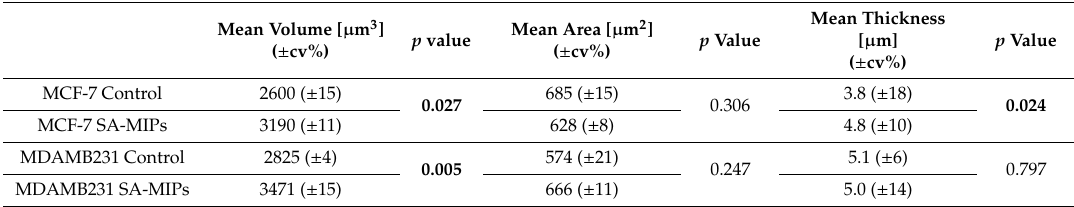
Table 1. Morphology parameters detected with DHC for MCF-7 cells and MDAMB231 cells after 72 h of SA-MIPs treatment. The results represent mean value of five positions in the wells for each condition. Statistical significance was determined with p values ≤ 0.05.